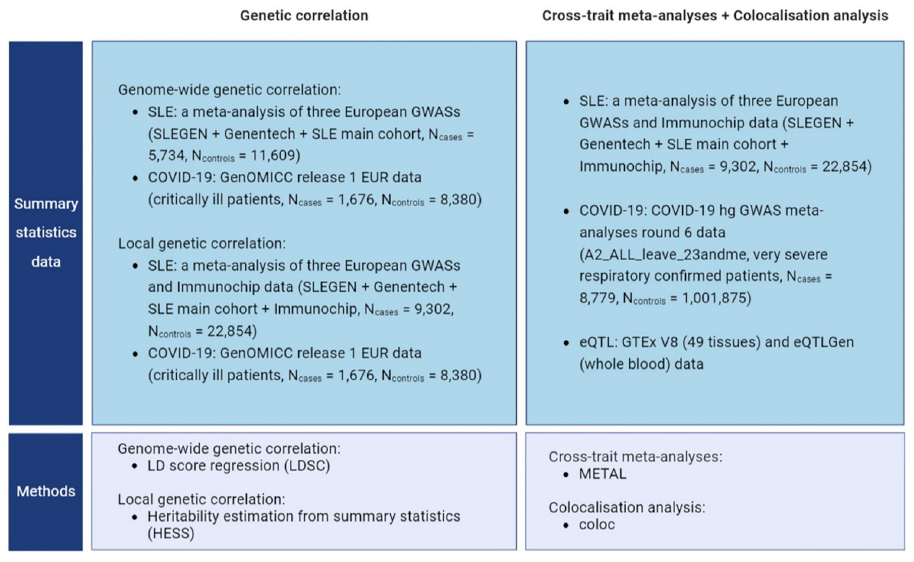
Fig 1. Overview of GWAS data used in the